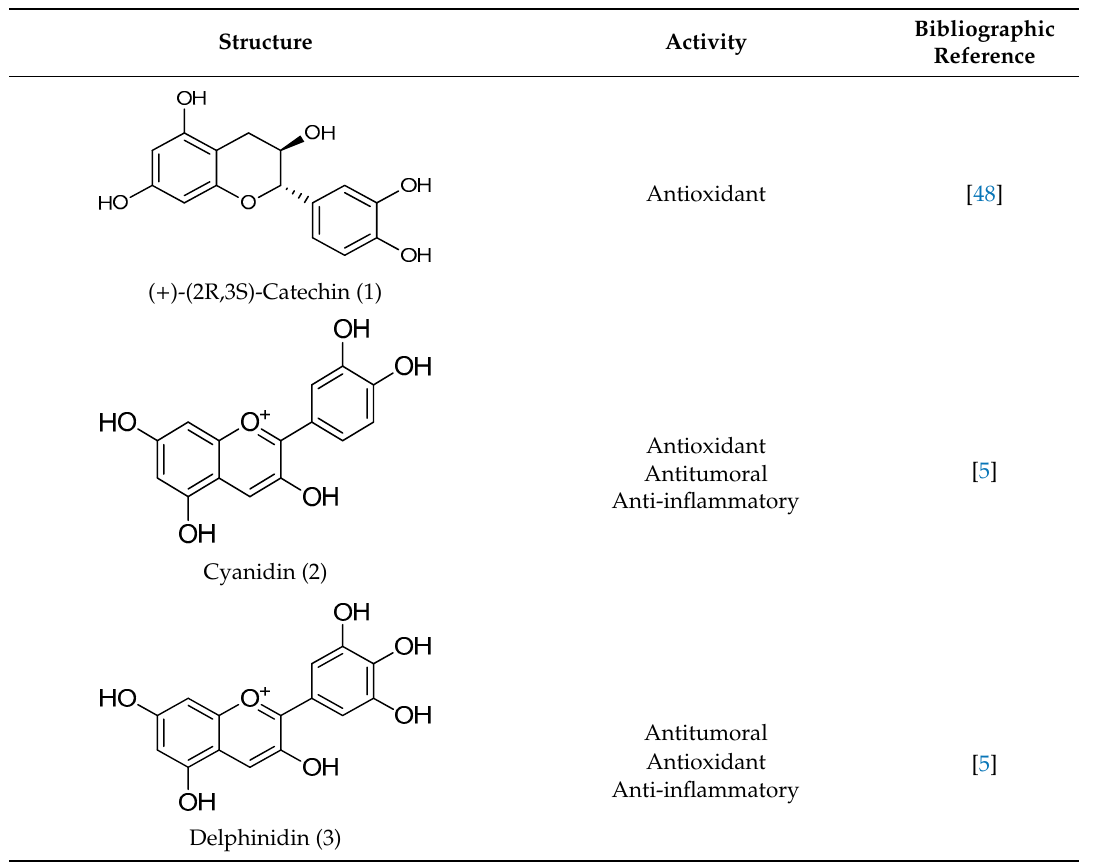
Table 1. Bioactive compounds present in pomegranate that have been demonstrated to have biological activity.